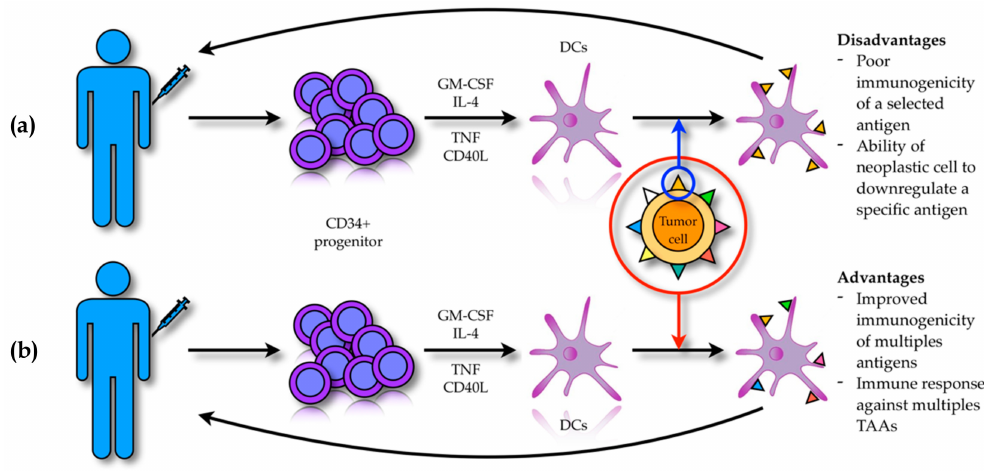
Figure 2. DC-based vaccines exploit the ability of DCs to cross-present TAAs in order to activate a T cell immune response against neoplastic cells. ( a ) CD34 + progenitors obtained from peripheral blood of the patient are exposed in vitro to a mixture of cytokines and di ff erentiate into DCs. These are loaded with a selected target TAA, activated and re-infused back into the patient. However, the poor immunogenicity of the selected TAA and the ability of tumor cells to actively down regulate specific antigen expression under the selective pressure of monoclonal T cells can hinder an e ff ective antitumor response. ( b ) DCs are activated using entire tumor cells: these DCs, when activated and re-infused, are able to stimulate a polyclonal and more e ff ective T cell response against tumor